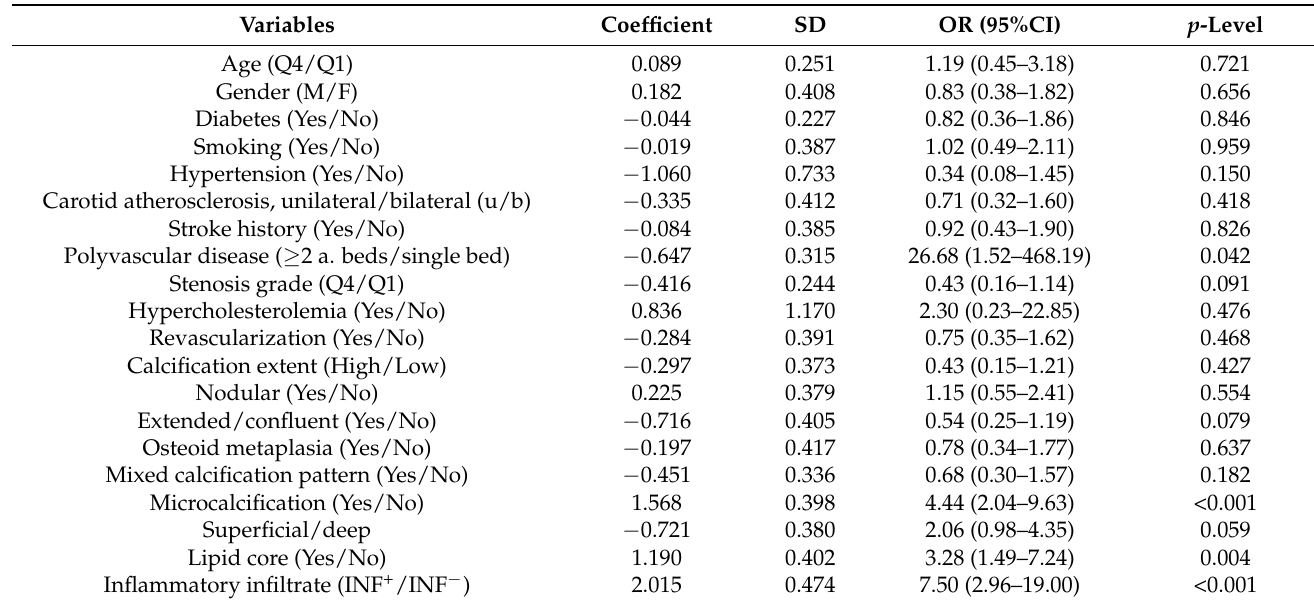
Table 3. Univariate logistic regression of variables associated with plaque ulceration.